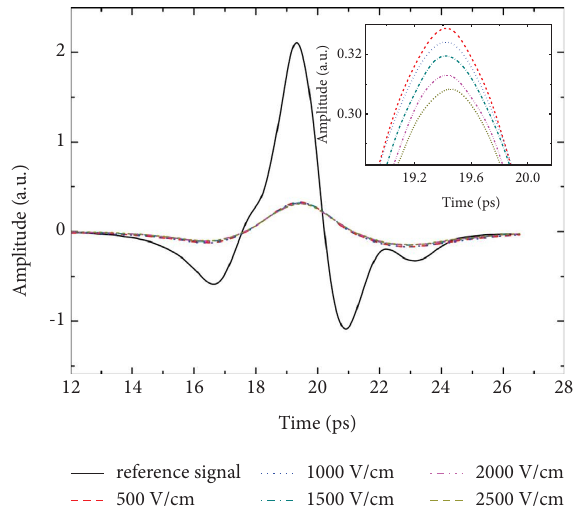
Figure 7: THz time-domain spectra of MWCNT aqueous dis- persion under diferent EF intensities.